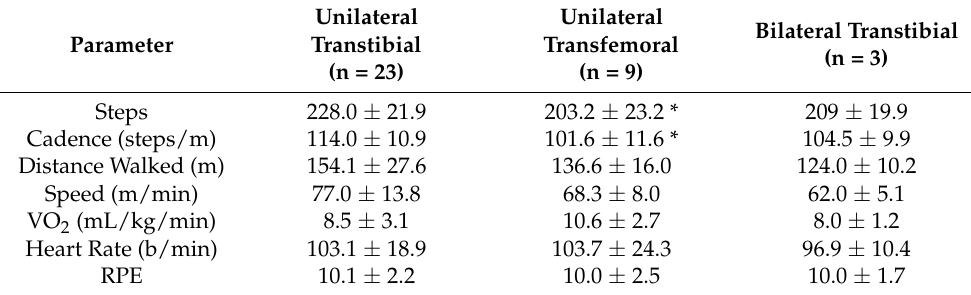
Table 3. Two-minute walk test outcome variables by the level of amputation.